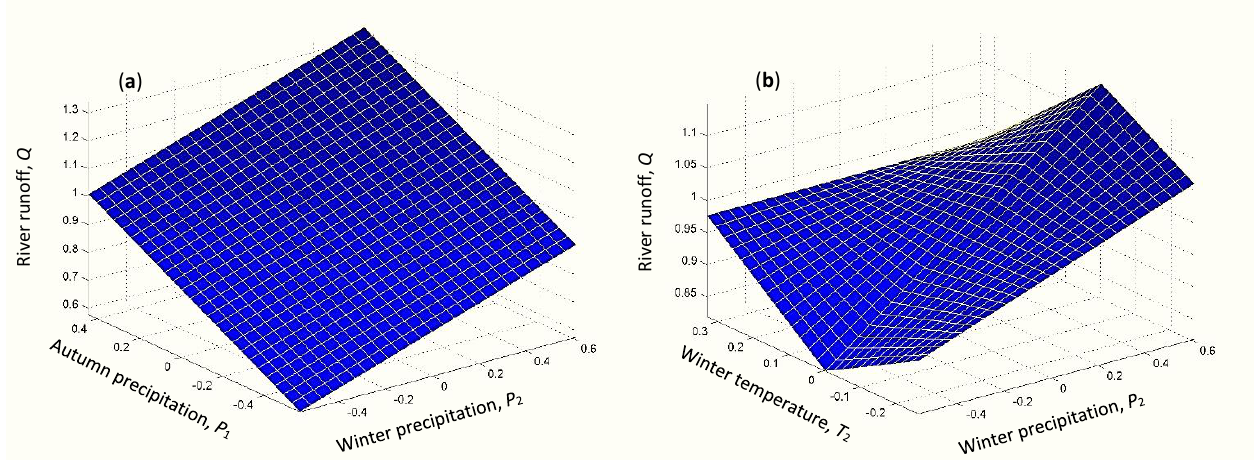
Figure 5. Dependence of April monthly floods (with ice motion) of the river Katun on air temperature and precipitation for preceding seasons (we show deviations of normalized monthly meteorological characteristics from their long-term averages, see notation for Equation (4)). ( a ) April runoff Q as a function of precipitation P 1 (IX–XI) and P 2 (XII–III); ( b ) April runoff Q as a function of temperature T 2 (XII–III) and precipitation P 2